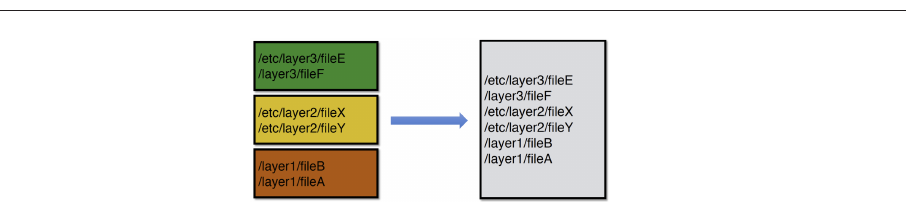
Figure 3. Docker images are built from layers.